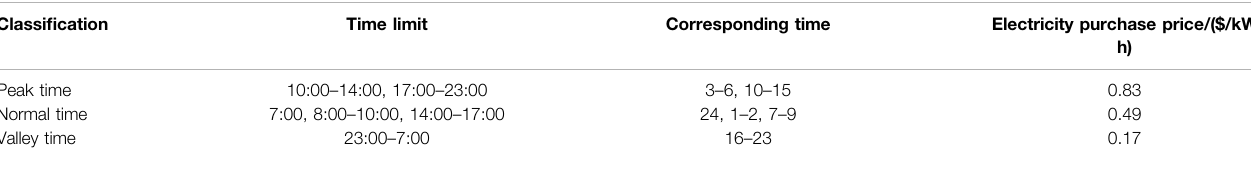
TABLE 2 | De fi nition of time-of-use electricity